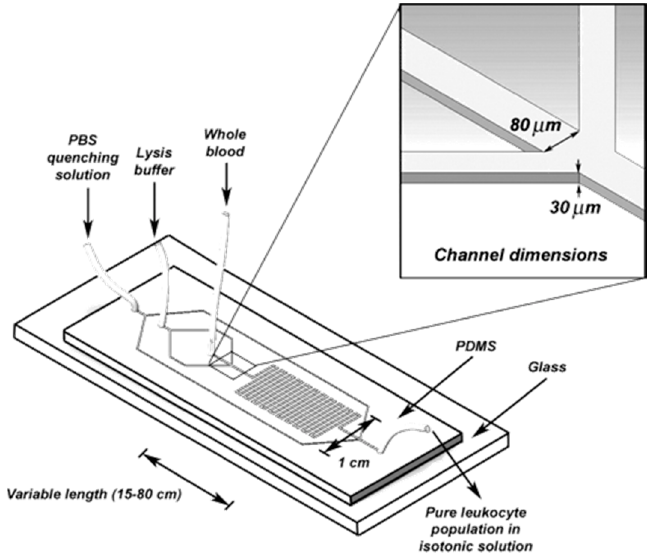
Figure 10. Schematic of a simple chamber and serpentine microfluidic channel for chemical lysis. Reproduced with permission from [65].